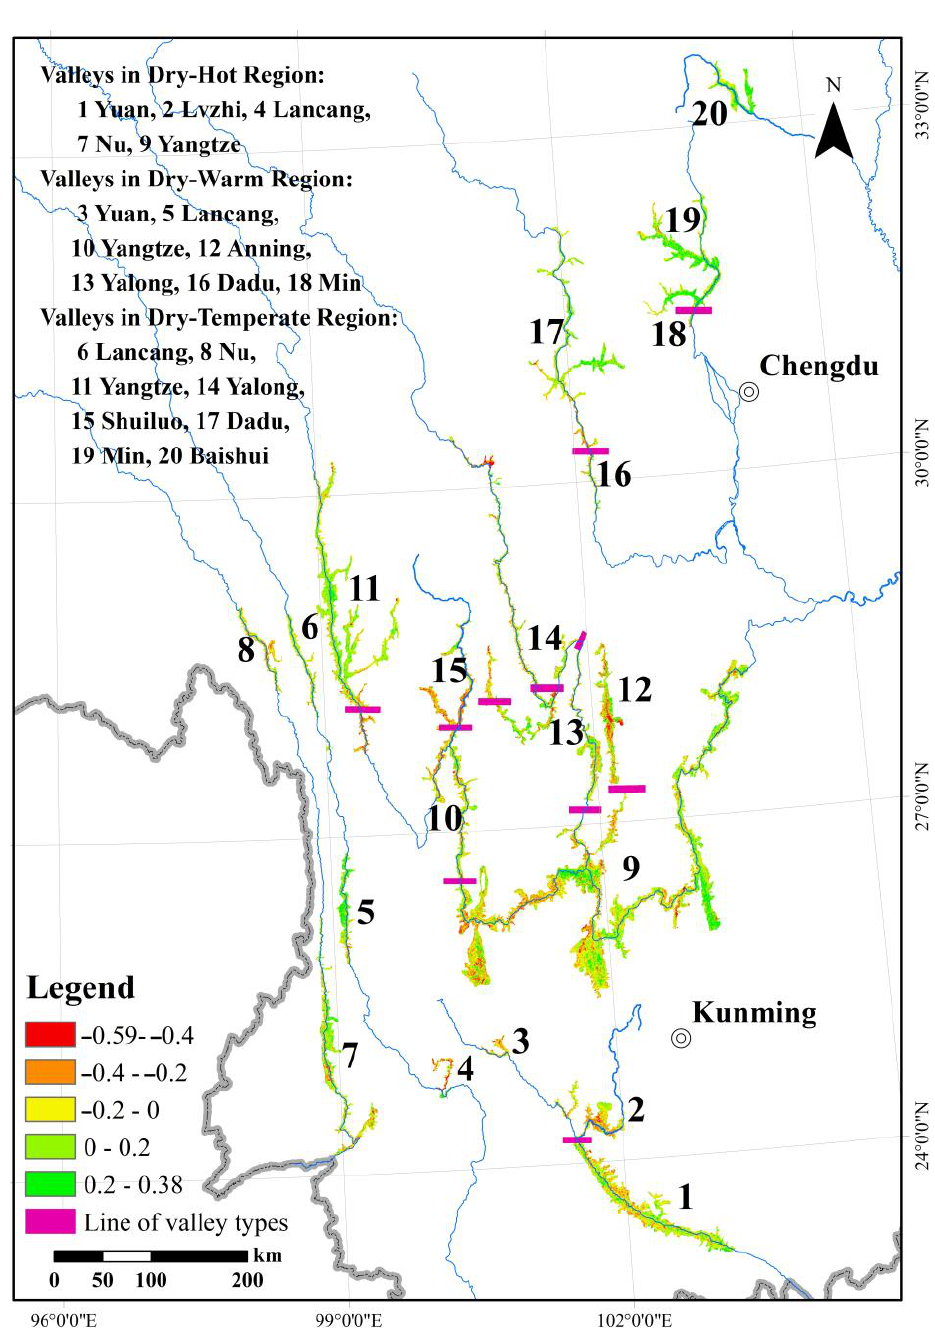
Figure 4. Changes in FVC in dry valleys between the periods 2000–2010 and 2011–2020. It can be concluded that for valleys with statistically significant temporal trends in FVC, the dynamics of FVC in the Yuan, Luzhi, and Lancang Rivers in the DHVs, the Yuan River of the DMVs, and in the Min and Baishui Rivers of the DTVs were significantly in- fluenced by the changes in annual precipitation, while anthropogenic activities may have contributed substantially to the dynamics of FVC in the Lancang and Jinsha Rivers of the DMVs and the Shuiluo River of the DTVs. Geographically, annual FVC increased signifi- cantly with annual precipitation in the dry–temperate valleys in the Min and Baishui